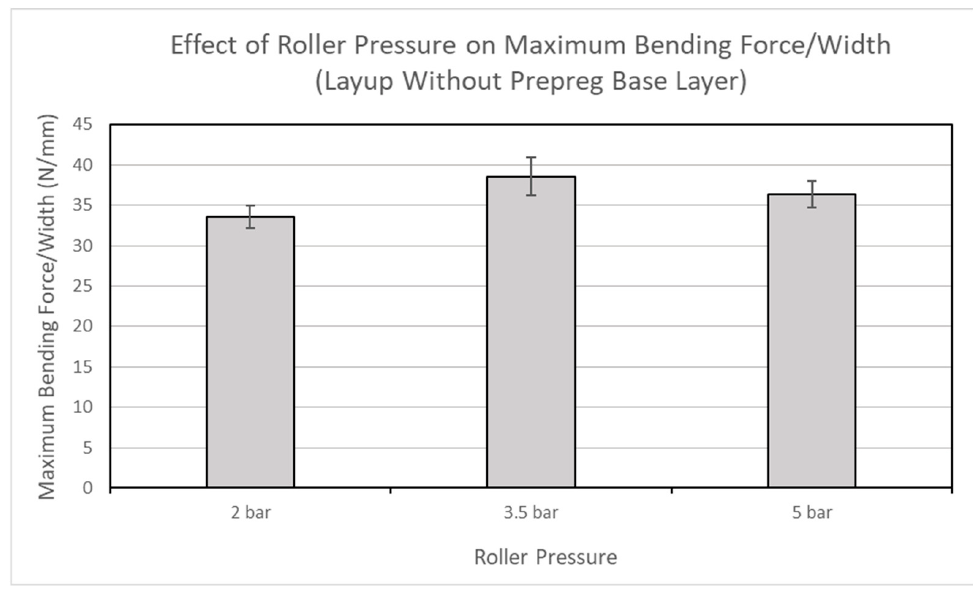
Figure 17. Effect of roller pressure and base layer on maximum bending force/width for layups without prepreg base layer.